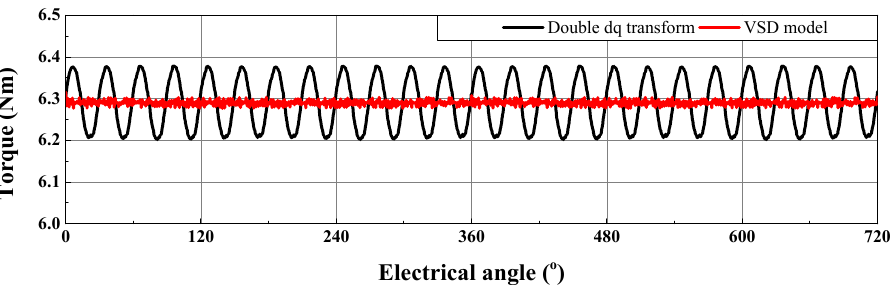
Figure 6. Torque profile of simulation results according to coordinate transformation method in healthy operation.